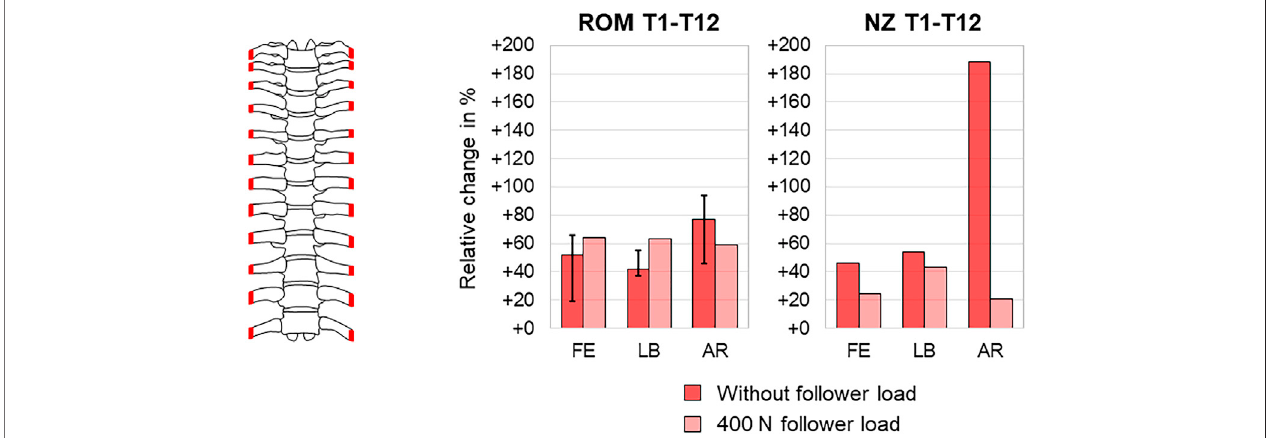
FIGURE 9 | Anterior rib cage removal. The relative range of motion (ROM) changes (medians with minimum and maximum values) of the thoracic spine (T1 – T12) without follower load according to Watkins et al. (2005), Mannen et al. (2015b), and Liebsch et al. (2017a), relative neutral zone (NZ) changes of the thoracic spine (T1 – T12)withoutfollowerloadaccordingtoLiebschetal.(2017a),andrelativerangeofmotion(ROM)andneutralzone(NZ)changesofthethoracicspine(T1 – T12)witha follower load of 400 N according to Mannen et al. (2018) in fl exion/extension (FE), lateral bending (LB), and axial rotation (AR) after anterior rib cage removal.